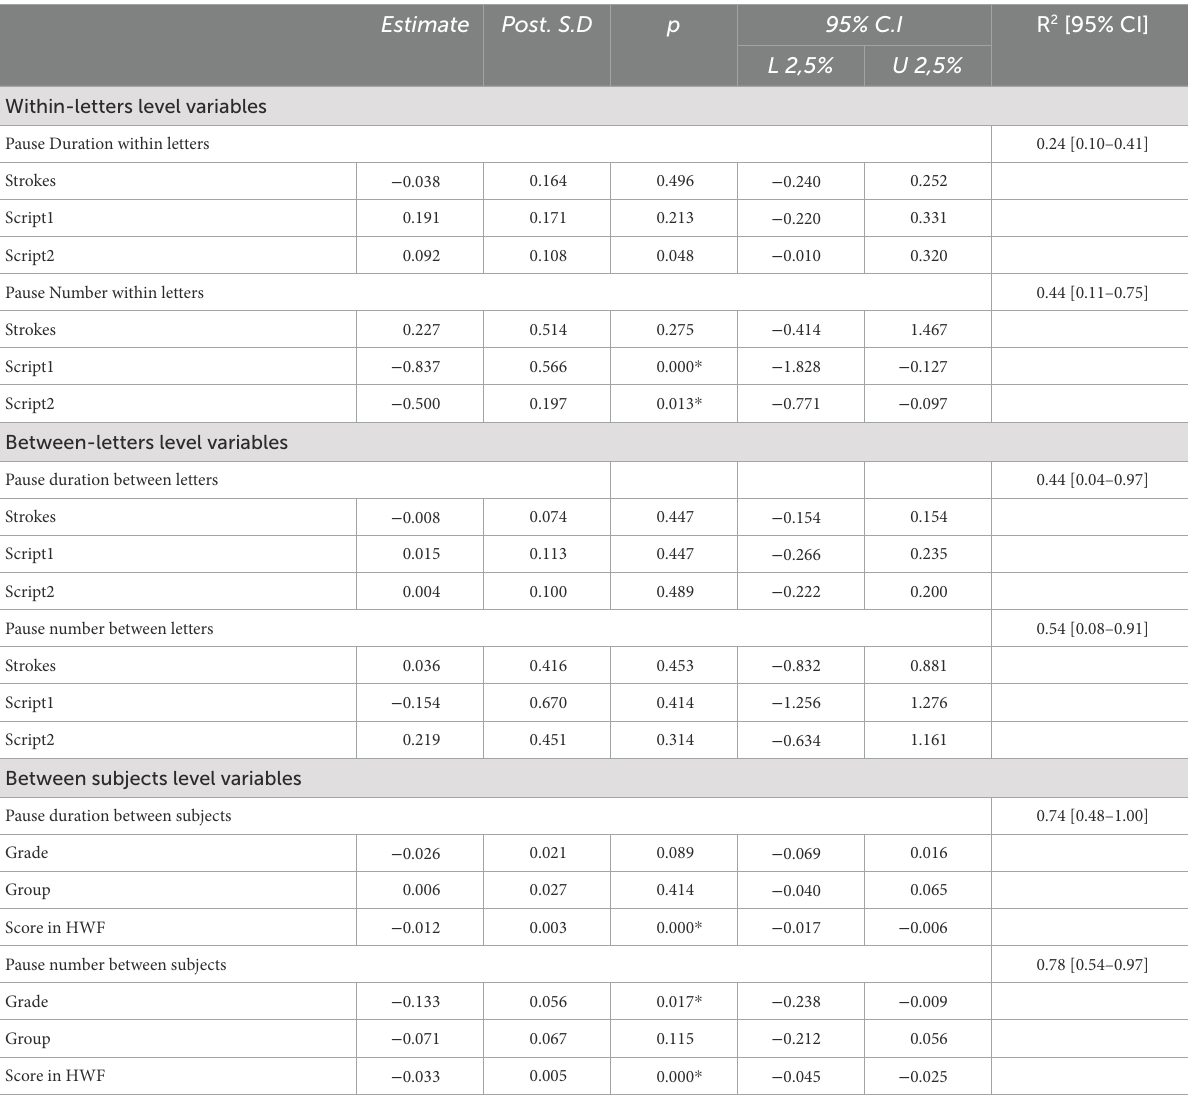
TABLE 5 Pause duration and pause number cross classified multilevel model per levels and the proportion of variance explained by the regression per level (R 2